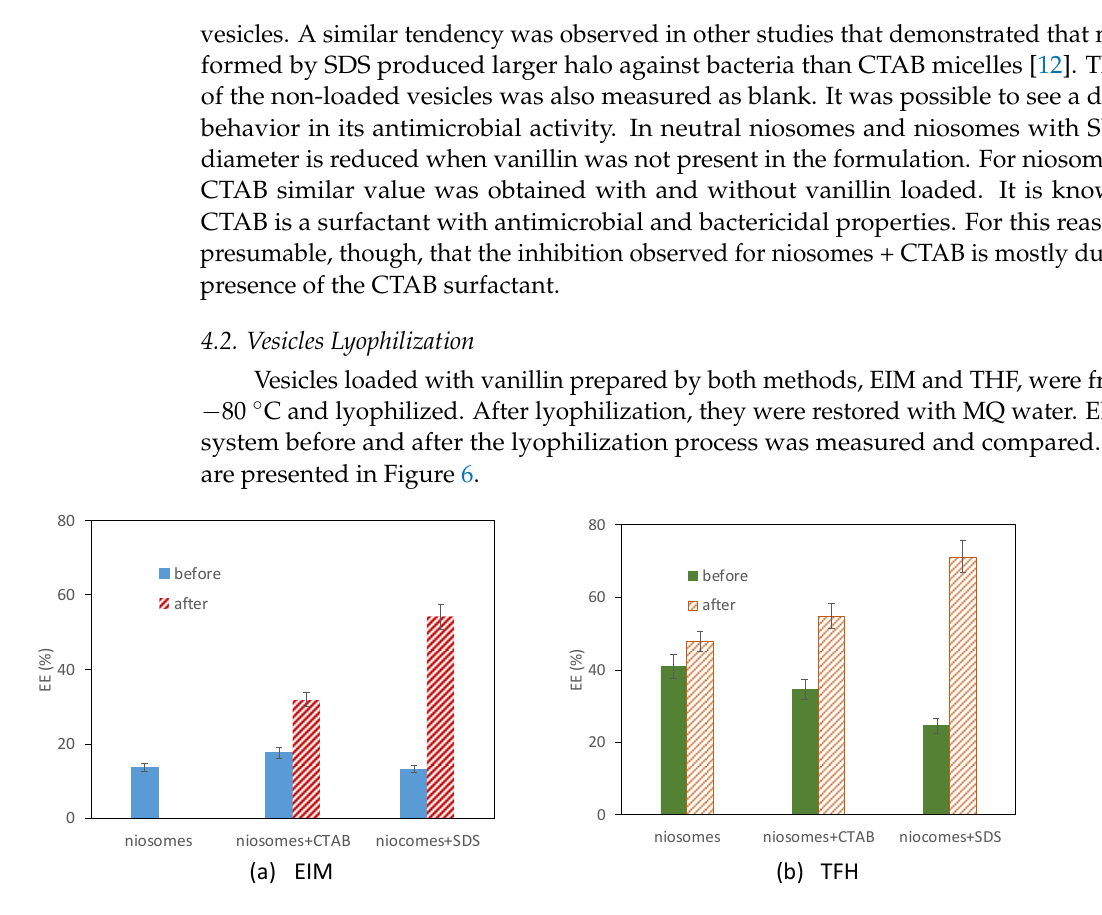
Figure 6. Encapsulation efficiency of vesicles before and after the lyophilization process, ( a ) prepared by ethanol injection method and ( b ) prepare by thin fim hydration method.